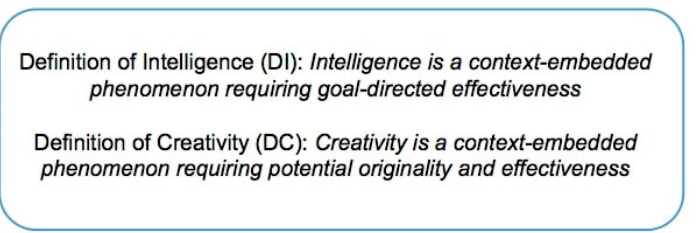
Figure 1. Definitions of Intelligence (DI) and Creativity (DC) adopted in the proposed theoretical framework.